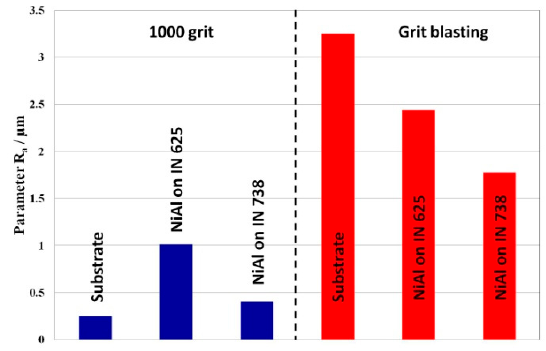
Figure 3. Comparison of roughness parameter R a measured on ground and grit-blasted substrates with aluminide coatings produced on these substrates.